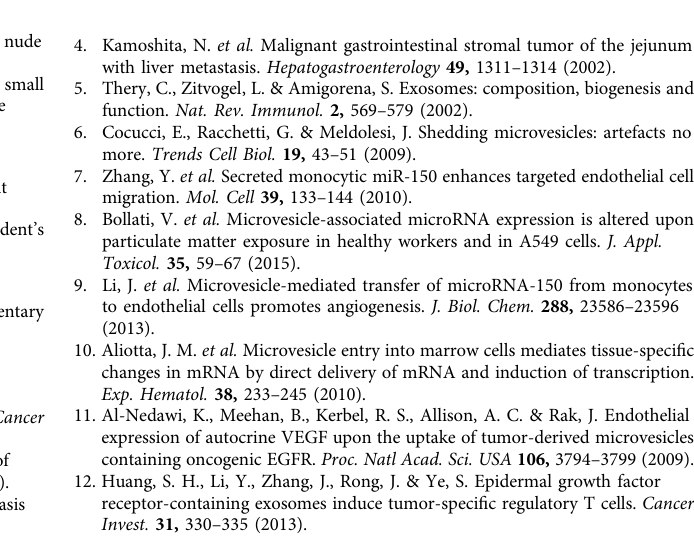
Figure 8 | Effects of upregulated liver HGF on hepatotropic metastasis. ( a ) Ratio of liver metastasis in GC tumor-implanted mice ( n ¼ 30). ( b ) Number of metastases in the liver of each mouse (the number in each group was marked). ( c ) Images of liver metastases in mice ( n ¼ 30). ( d ) The weight of tumours in c . ( e ) Immunohistochemistry (IHC) analysis of HGF and c-MET expression in GC liver metastases. ( f ) IHC analysis of p-c-MET in the liver metastases of each group. ( g ) Western blot analysis of HGF, p-c-MET and c-MET in GC liver metastases. The data represent the mean ± s.e.m. * P o 0.05, ** P o 0.01 (Student’s